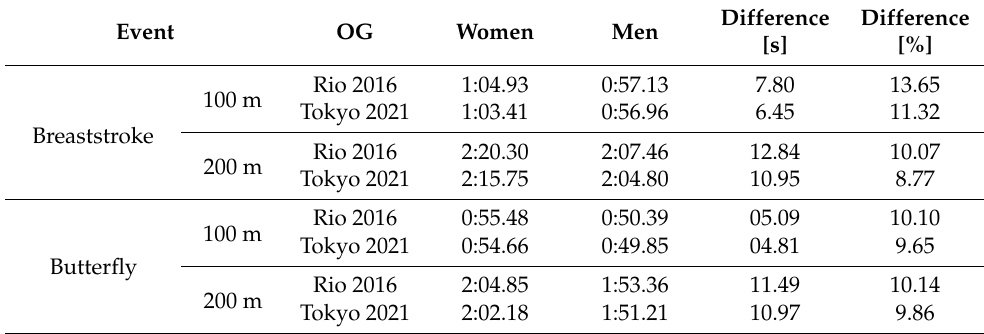
Table 2. Results and differences for the winners in the Rio Olympics in 2016 and the results predicted for the Olympics in 2021.